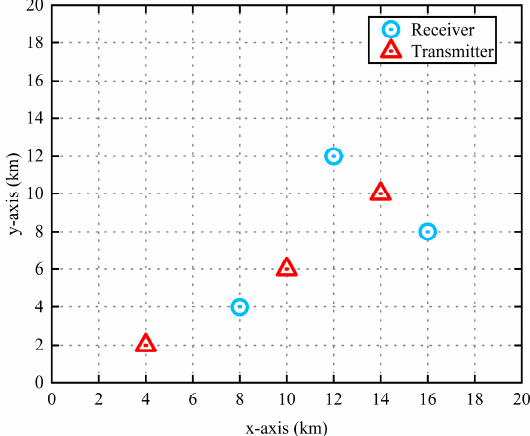
Figure 5. Optimal antennas’ geometry distribution.